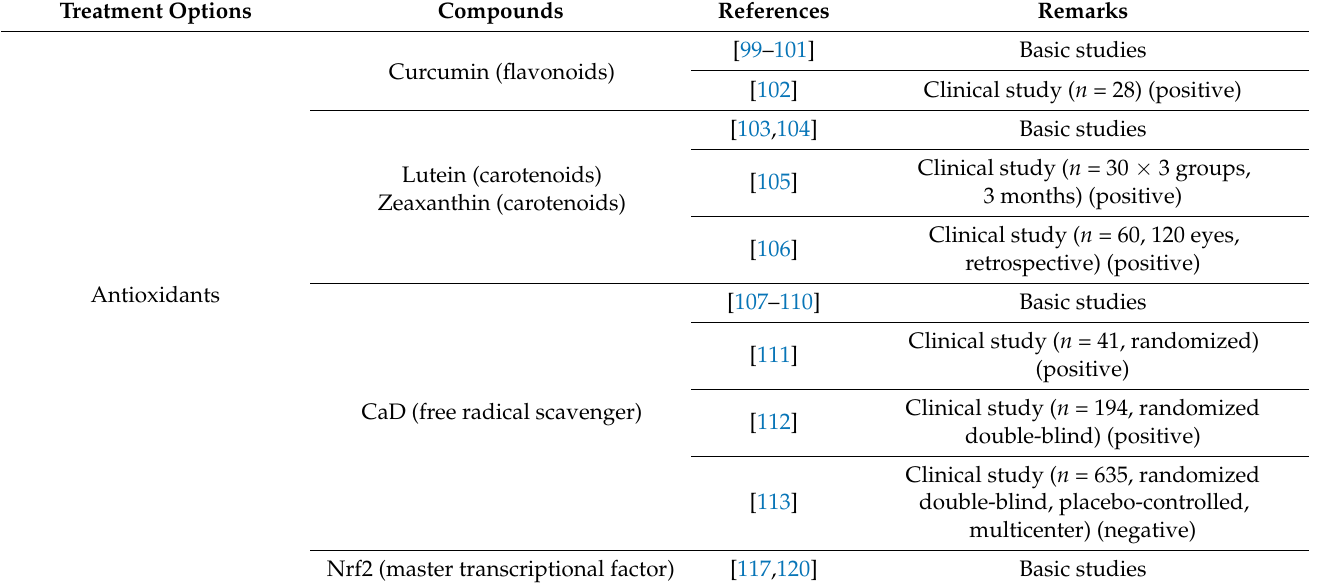
Table 1. Summary of treatment options for early diabetic